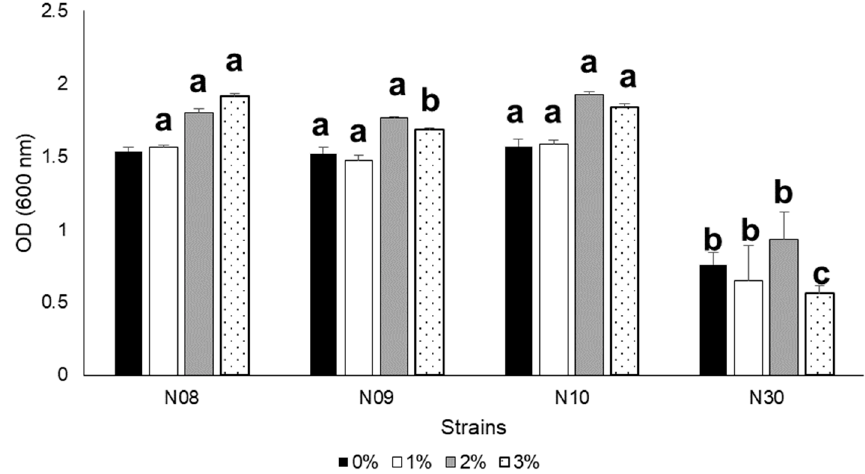
Figure 3. Effect of NaCl concentrations on growth of GABA producing-four strains. Values indicate the average ± standard deviation ( n = 3). Different letters denoted in column show significant difference ( p < 0.05).